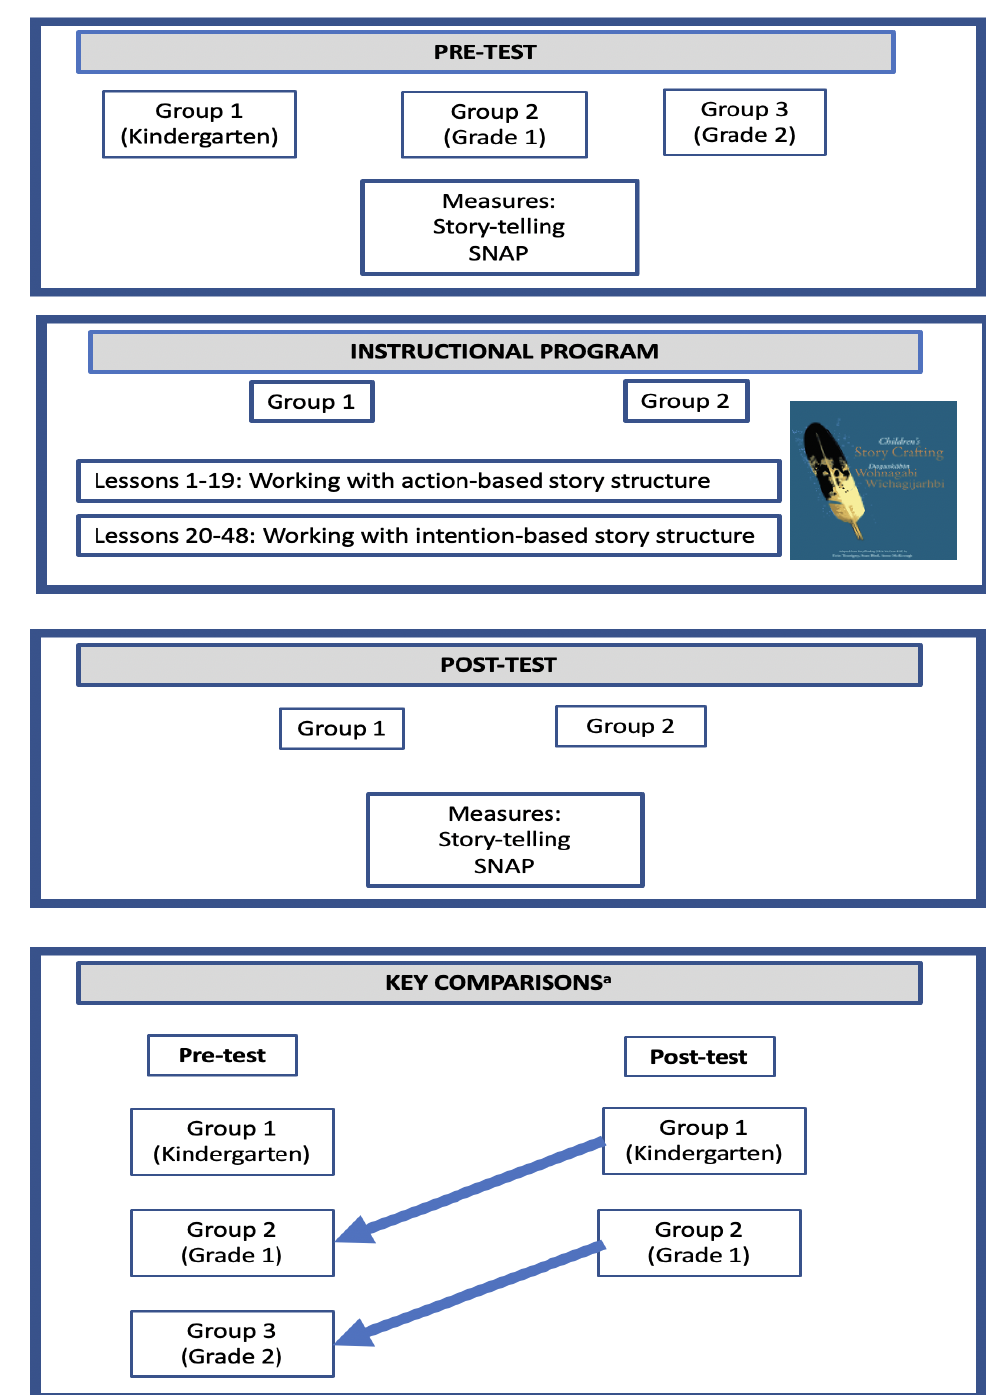
Figure 1: An overview of the experimental design and key